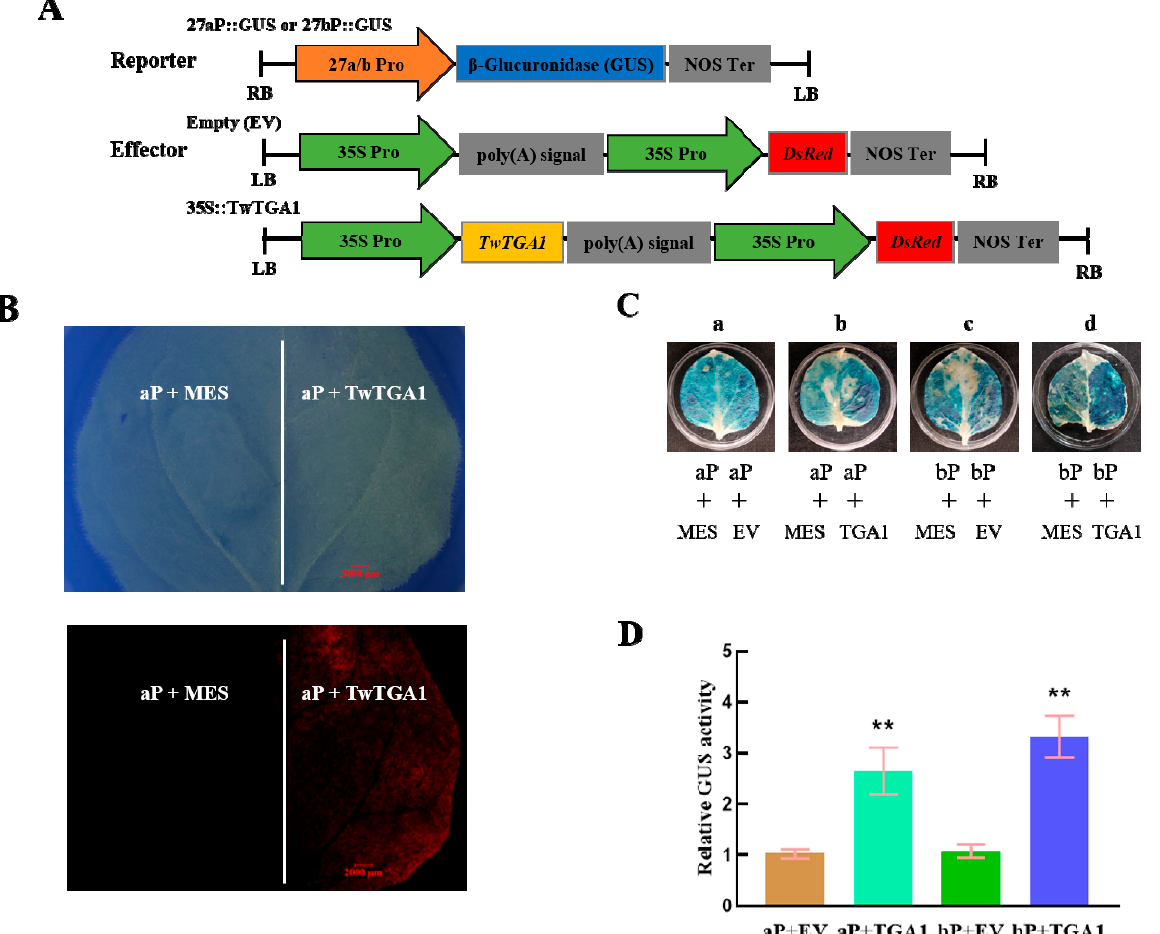
Figure 4. Activation of the TwTPS7a/b promoters by transient overexpression of TwTGA1 in tobacco leaves. ( A ) Schematic diagrams of the reporter and effector vectors for GUS staining and GUS fluorimetric assays. LB and RB, left and right T-DNA borders. ( B ) Red fluorescent signals in transiently transformed tobacco leaf. Top panel: bright field; bottom panel: RFP fluorescence. Scale bar: 2000 µ m. aP, 27aP::GUS; TwTGA1, 35S::TwTGA1; MES, 2-(N-morpholino)ethanesulfonic acid (MES) buffer. ( C ) The GUS staining analysis of the infiltrated tobacco leaves. Different combinations of the mixed bacterial suspension were infiltrated into the left and right sides of the midrib in the same tobacco leaves, respectively. a, bacterial suspension harboring 27aP::GUS+EV was infiltrated into the right side of the midrib, while 27aP::GUS+MES into the left side of the midrib (as the control) in the same tobacco leaf. b, bacterial suspension harboring 27aP::GUS+35S::TwTGA1 was infiltrated into the right side of the midrib, while 27aP::GUS+MES into the left side of the midrib (as the control) in the same tobacco leaf. c, bacterial suspension harboring 27bP::GUS+EV was infiltrated into the right side of the midrib, while 27bP::GUS+MES into the left side of the midrib (as the control) in the same tobacco leaf. d, bacterial suspension harboring 27bP::GUS+35S::TwTGA1 was infiltrated into the right side of the midrib, while 27bP::GUS+MES into the left side of the midrib (as the control) in the same tobacco leaf. aP, 27aP::GUS; bP, 27bP::GUS; TwTGA1, 35S::TwTGA1; EV, empty vector; MES, MES buffer. ( D ) GUS activity analysis showing that TwTGA1 activates the promoters of TwTPS27a/b . The value of relative GUS activity was measured by the ratio of GUS activity in the right side of the midrib to that of the left side of the midrib in the same tobacco leaf. All data presented here are means±SD of three biological replicates, and these assays were repeated at least three times with similar results. Sta- tistical significance was determined using Student’s t -test (**, p < 0.01). 3. Discussion To explore the molecular basis for the regulation of MS genes, TwTPS27a and TwTPS27b , in triptolide biosynthesis, the promoters of TwTPS27a (1496 bp, − 1392 to +124 bp) and TwTPS27b (1862 bp, − 1738 to +124 bp) were isolated from T. wilfordii using the methods of SiteFinding-PCR and FPNI-PCR (Figure S1). In silico analysis of the TwTPS27a and TwTPS27b promoters revealed that many common cis -regulatory ele- ments existed in their promoter regions (the sequences between TwTPS27a promoter from − 1115 to +124 bp and TwTPS27b promoter from − 1088 to +124 bp were highly ho- mologous, with 93.0% identity, Figure S8) (Figure 2A), suggesting that both promoters have similar regulation traits. In the present study, the promoter activity of 27aP (full-length promoter of TwTPS27a , 1496 bp) was not significantly different from that of 27bP-1 (full-length promoter of TwTPS27b , 1862 bp) in driving the GUS expression in transiently transformed tobacco leaves (Figure 2C). Furthermore, the promoter activities of 27aP and 27bP-1 were both significantly increased by MeJA treatment, to a similar fold